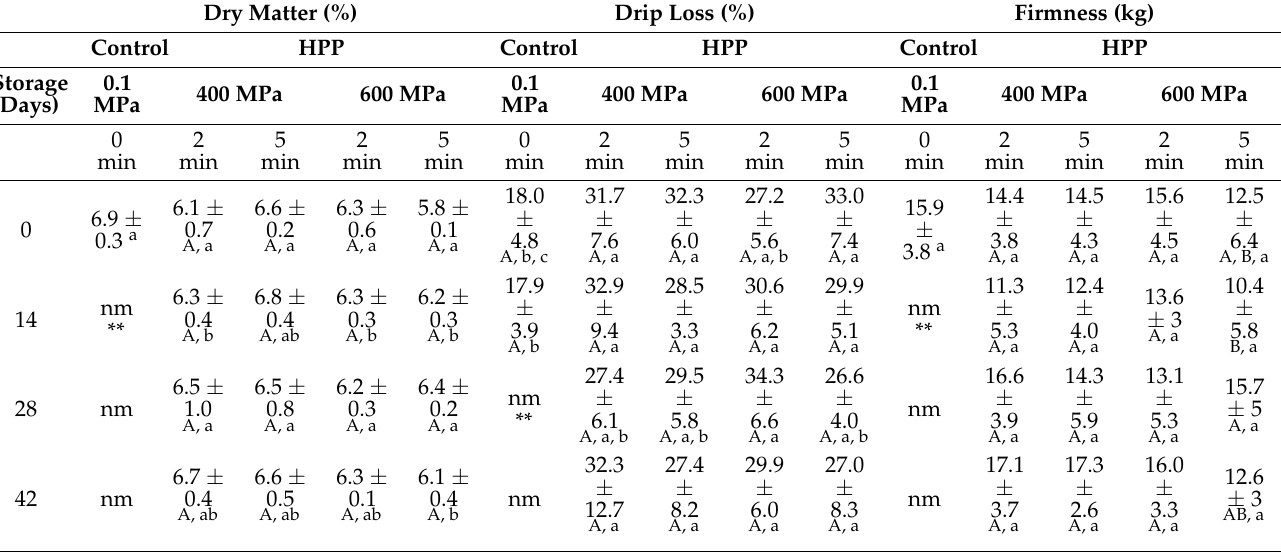
Table 3. Dry matter content (%), drip loss (%) and firmness (kg) for pieces of cauliflower measured before (control) and after HPP (400 and 600 MPa). The samples were stored for up to 42 days in cold storage (4 ◦